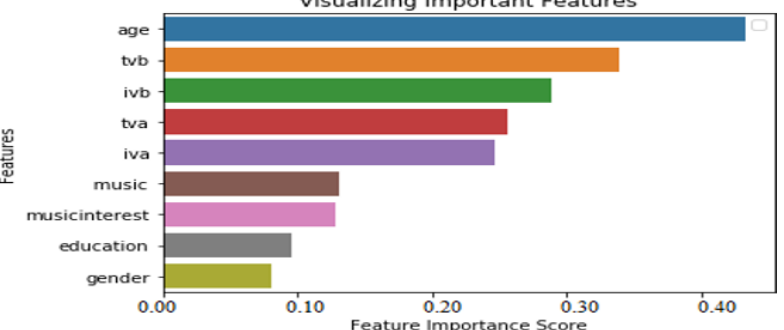
Figure 3. Visualizing Important